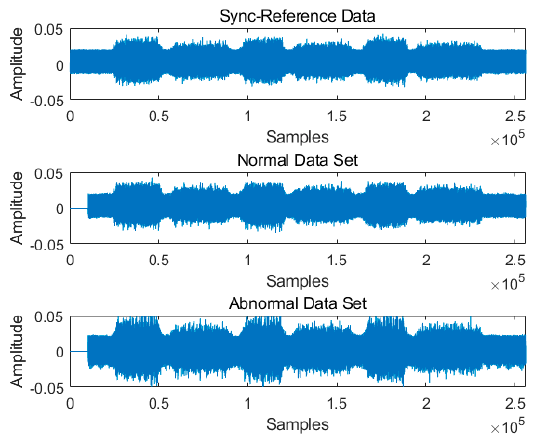
Figure 9. Time synchronization of raw signal data.